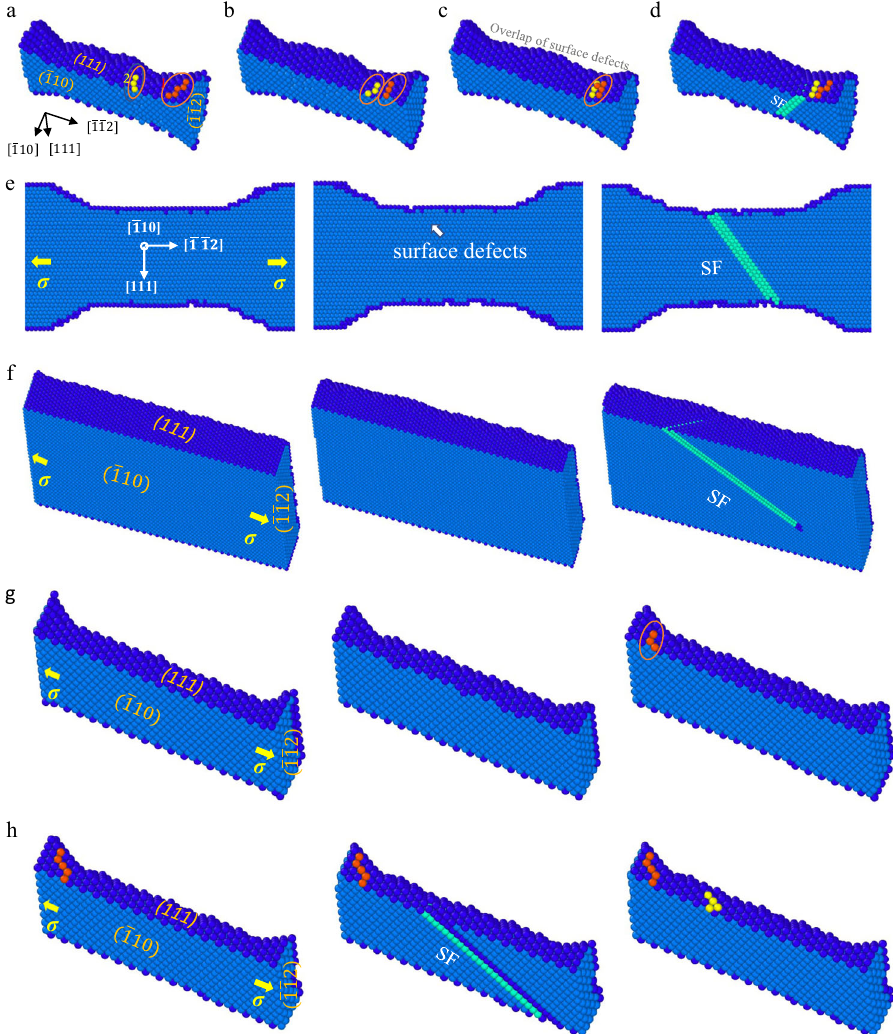
Fig. 4 MD simulations of dislocation nucleation mechanism in metallic NWs under < 112 > tension at the temperature of 800 K and a strain rate of 10 5 s − 1 . a Two atomic steps (steps 1 and 2) formed by surface diffusion in a 6-nm-diameter Ag NW. b Surface-diffusion-assisted migration of atomic steps (steps 1 and 2) to the right side of NW. c Overlap of surface defects. d Nucleation and propagation of leading partial dislocations at the overlapping position of surface defects. e Dislocation nucleation assisted by single-atom diffusion at the surface of a 6-nm-diameter Ag NW in a random and chaotic way. f Dislocation nucleation in a 20-nm-diameter Ag NW with weak surface diffusion. g Dislocation nucleation in a 6-nm-diameter Pt NW with nearly no surface diffusion. h No diffusional events during plastic fl ow in the Pt NW causing that surface steps remained immobile. Surface steps caused by full dislocation activities are colored by orange and yellow in g , h . The color coding corresponds to surface atoms in blue color, atoms in SFs in light green color, and atoms in perfect face-centered cubic (FCC) crystal arrangement in light